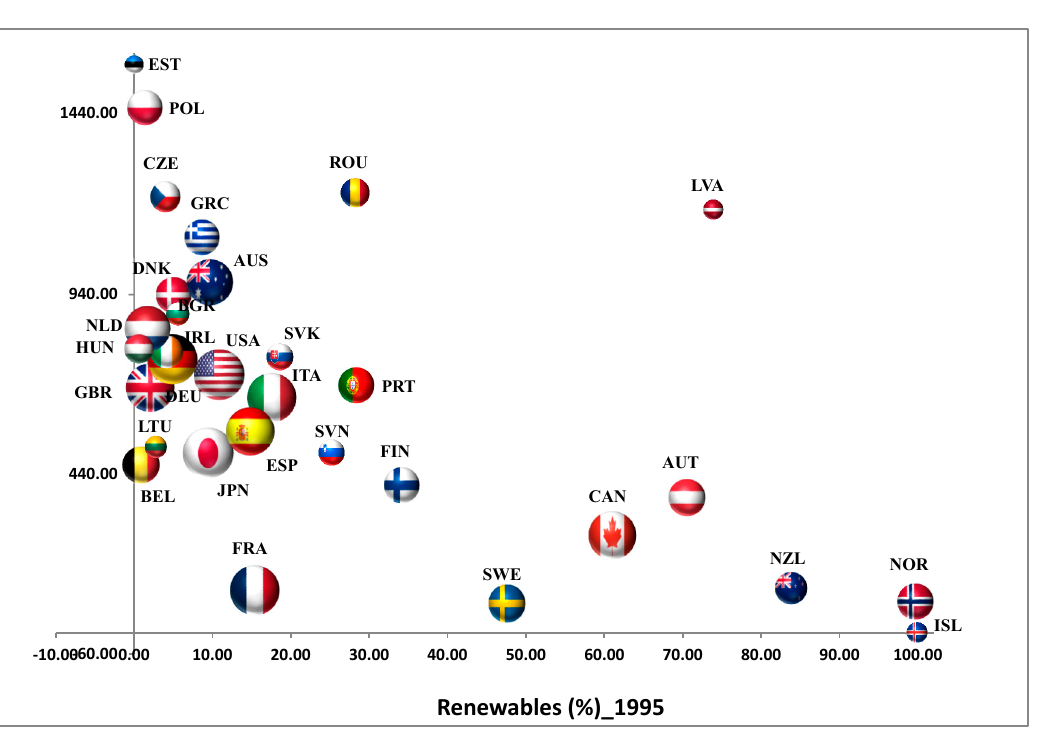
Figure 1. Electricity CO 2 intensity vs. Renewables (%) Year _1995. Note: Sphere size is determined based on each country’s Total GDP ranking in the dataset. Authors’ elaboration. Data sources: [49], [52– 55].